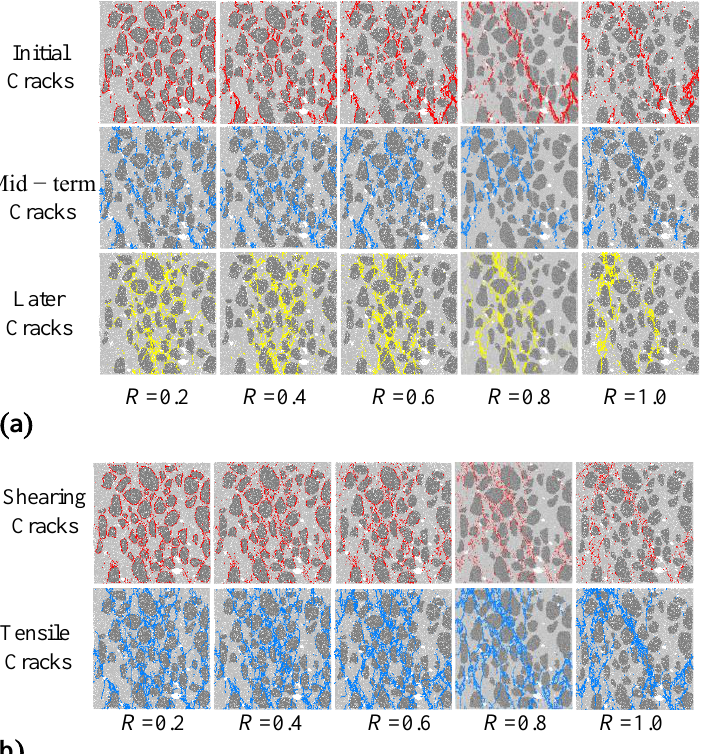
Figure 8. Spatial distribution of cracks. ( a ) Development of cracks in different stages; ( b ) distribution of shearing cracks and tensile cracks.